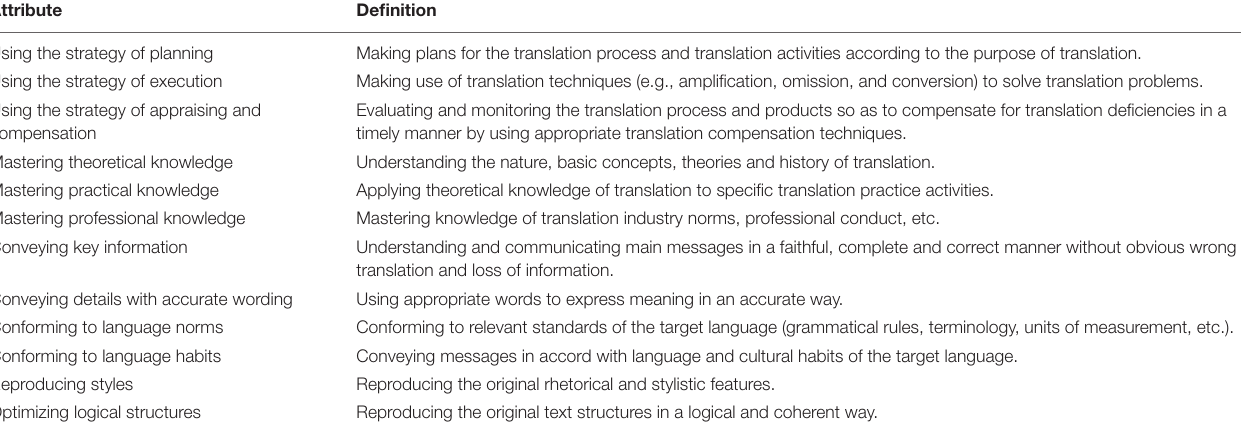
TABLE 2 | The attribute pool of translation competence. Attribute